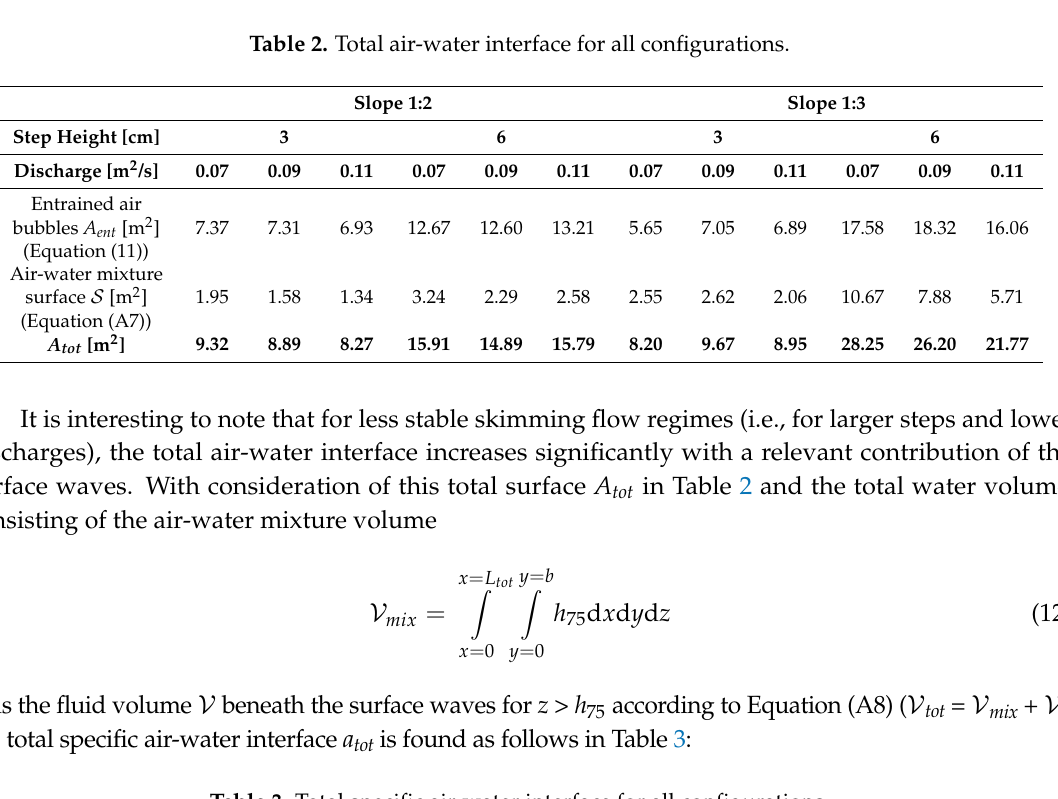
Table 3. Total specific air-water interface for all configurations. Slope 1:2 Slope 1:3